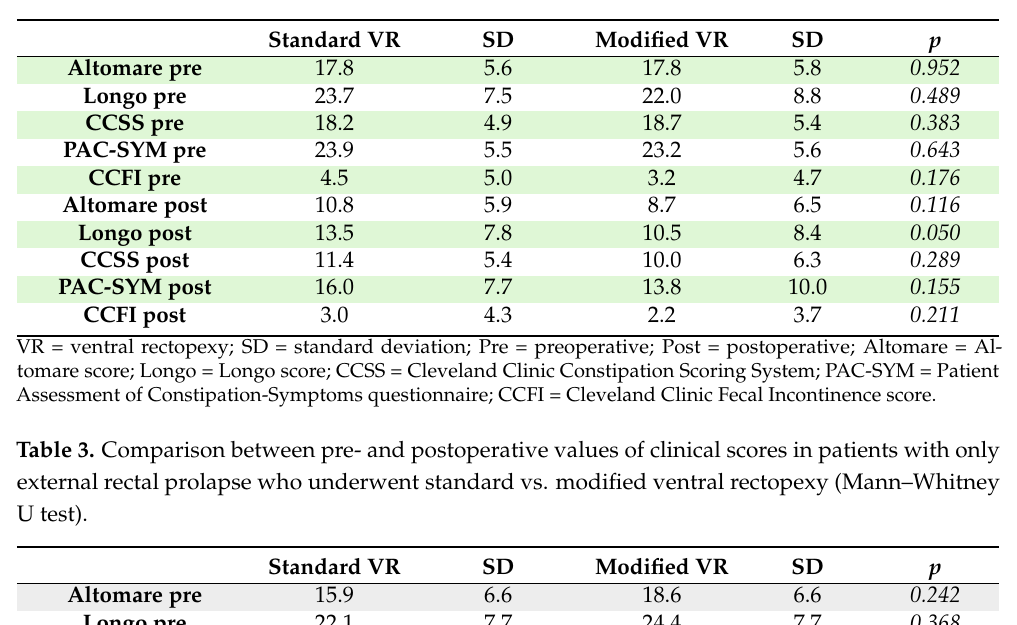
Table 2. Comparison between pre- and postoperative values of clinical scores in patients with only internal rectal prolapse who underwent standard vs. modified ventral rectopexy (Mann–Whitney U test).